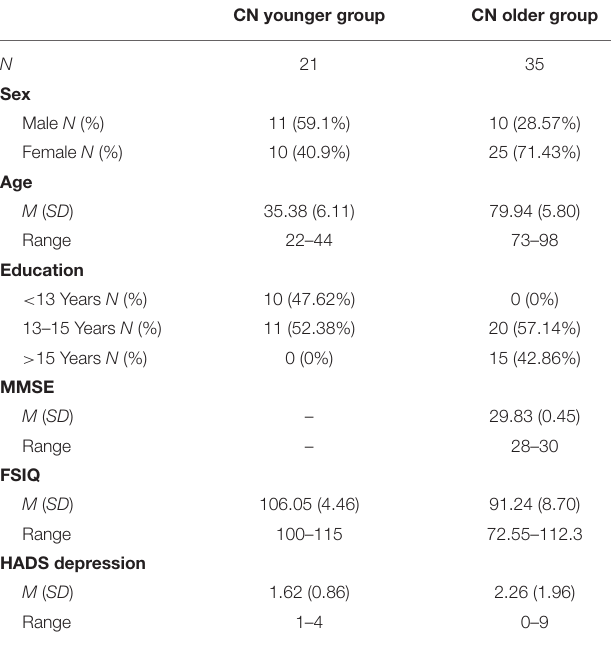
TABLE 1 | Demographic and Neuropsychological characteristics of CN old and CN younger